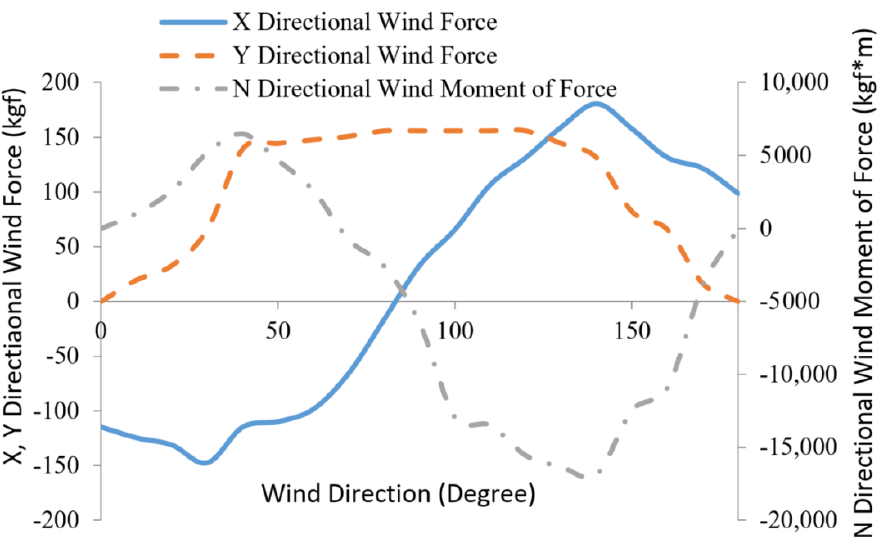
Figure 12. Wind analysis diagram in different wind directions.